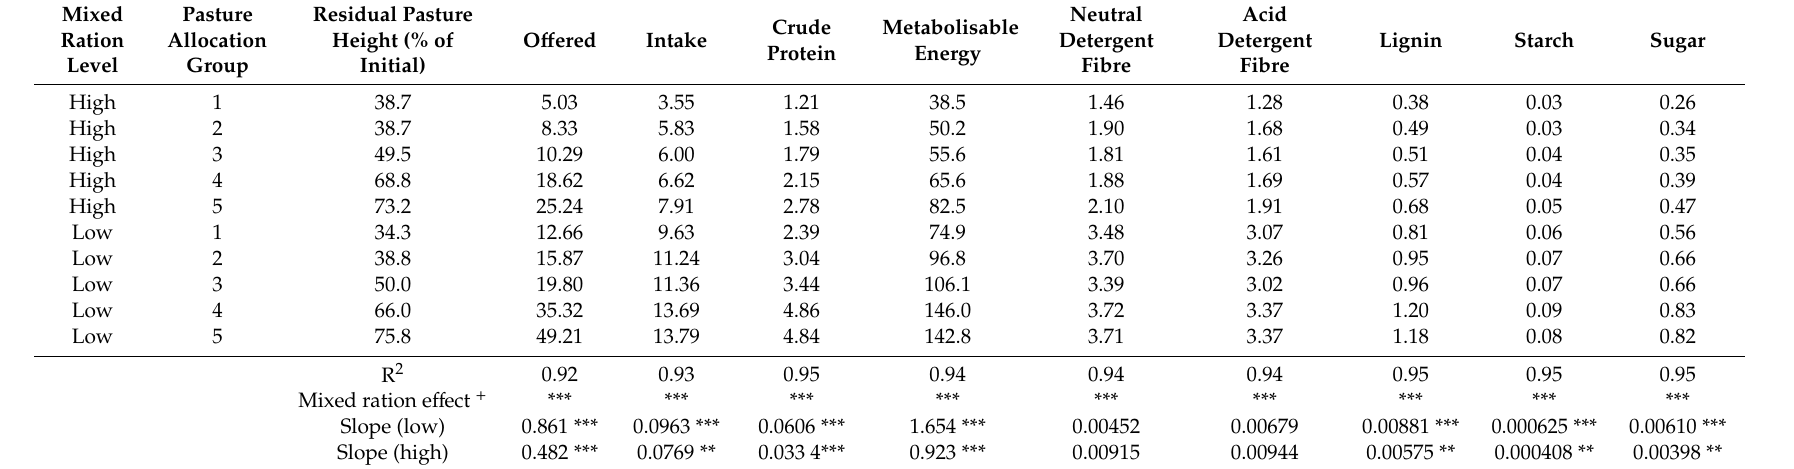
Table 5. The nutrient (kg dry matter (DM) / cow / day) and metabolisable energy (MJ / cow / day) intake of the consumed pasture for each treatment group. Mixed